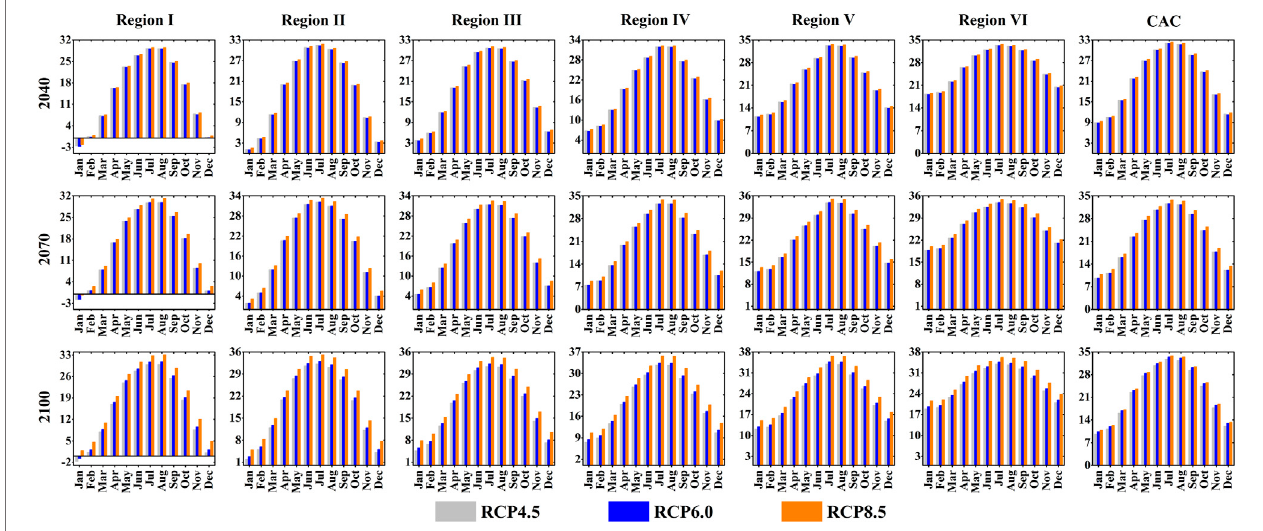
FIGURE 11 | Projected monthly average Tmax for 2040, 2070, and 2100 with different RCPs over CAC.